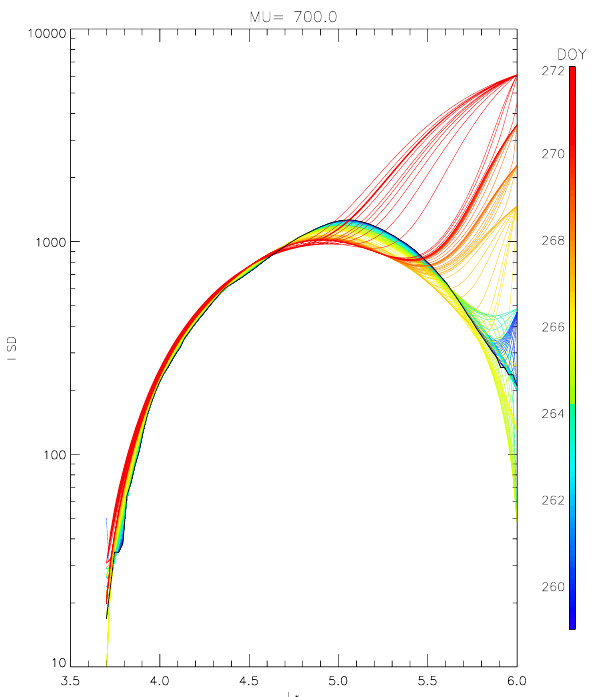
Figure 12. Time development of phase space density from a simu- lation using the MHD-based radial diffusion coefficient multiplied by 3.